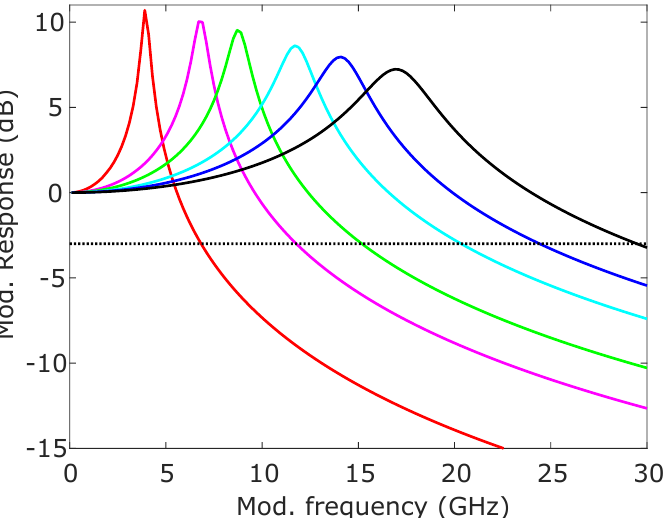
Figure 5. Small signal modulation response for a total injection modulation according to Equation (16) and for different bias injection levels: µ = 2—red line; µ = 4—magenta line; µ = 6—green line; µ = 10—cyan line; µ = 14—blue line; and µ = 20—black line. The straight dotted line shows the level of − 3